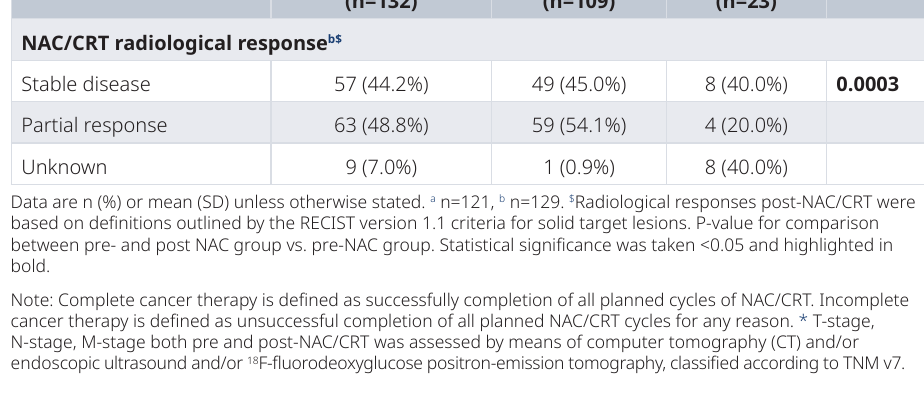
Pre-NAC/CRT Post-CRT/NAC Difference (95% CI) P-value (n=109) (n=109)